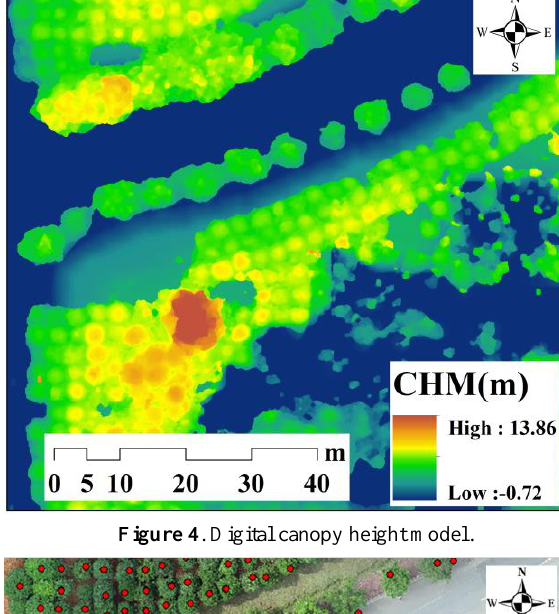
Figure 4 . Digital canopy height model.